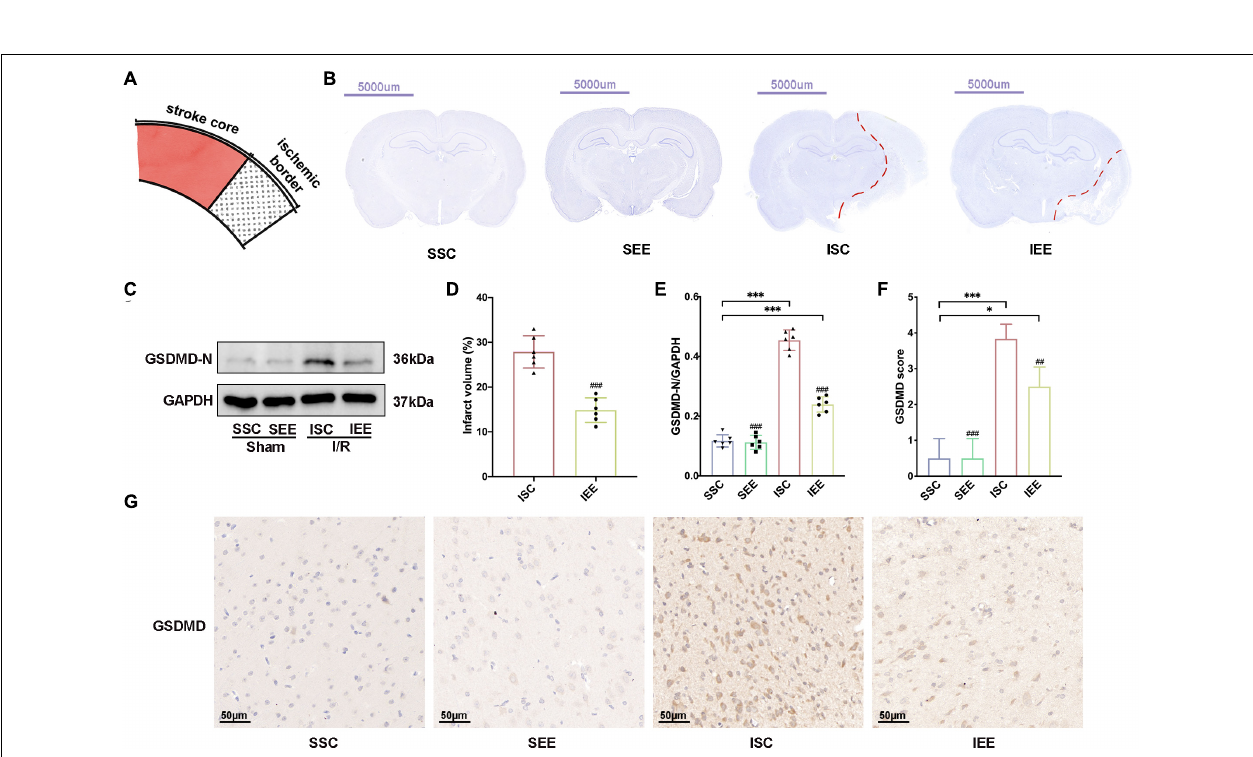
FIGURE 3 | Enriched environment decreased ischemic infarction and inhibited pyroptosis after I/R injury. (A) Schematic brain with a highlight of the ischemic border. (B,D) Representative cresyl violet stained brain slices and quantification of cerebral infarct volume percentage. Scale bars, 5000 µ m. n = 6. (C,E) Protein levels of GSDMD-N in peri-infarct tissues. n = 6. (G,F) Representative IHC staining images for GSDMD in the penumbra and IHC score of GSDMD in the penumbra. Scale bars, 50 µ m. n = 6. Data are expressed as mean ± SD. * p < 0.05, *** p < 0.001 vs. SSC group; ## p < 0.01, ### p < 0.001 vs. ISC group.